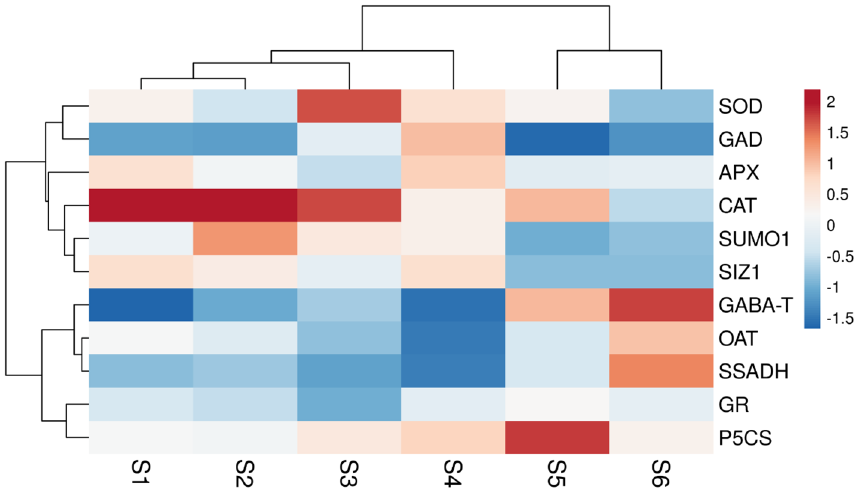
Figure 1. Heat map was created in R using the pheatmap package for representing SUMO1/SIZ1 accompanying ROS scavenging, proline biosynthesis and GABA shunt pathway genes expression in rose flowers during opening and senescence. Stage 1, closed buds; stage 2, closed and heavily pigmented bud; and stage 3, flower with their outer petal whorl just unfurled as commercial harvest stage, stage 4, sepals completely opened, petal starting to unfold (4 days after harvest); stage 5, petals completely unfolded (8 days after harvest); and stage 6, flower completely senesced with petal bluing (12 days after harvest).